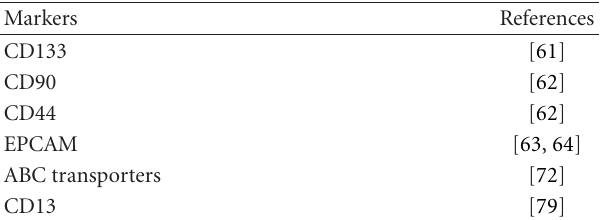
Table 3: Markers for cancer stem cell of HCC in recent reports.